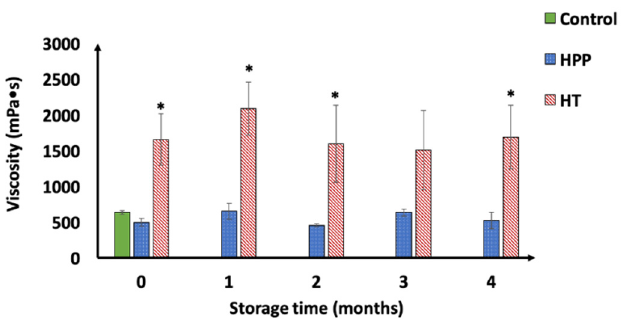
Figure 3. Viscosity changes of control, HPP- (600 MPa, 3 min), and HT-treated (63 °C, 3 min) puree during 4 months of storage at 4 °C. Denotation of “*” indicates significant difference among treatments at each sampling point ( p < 0.05).